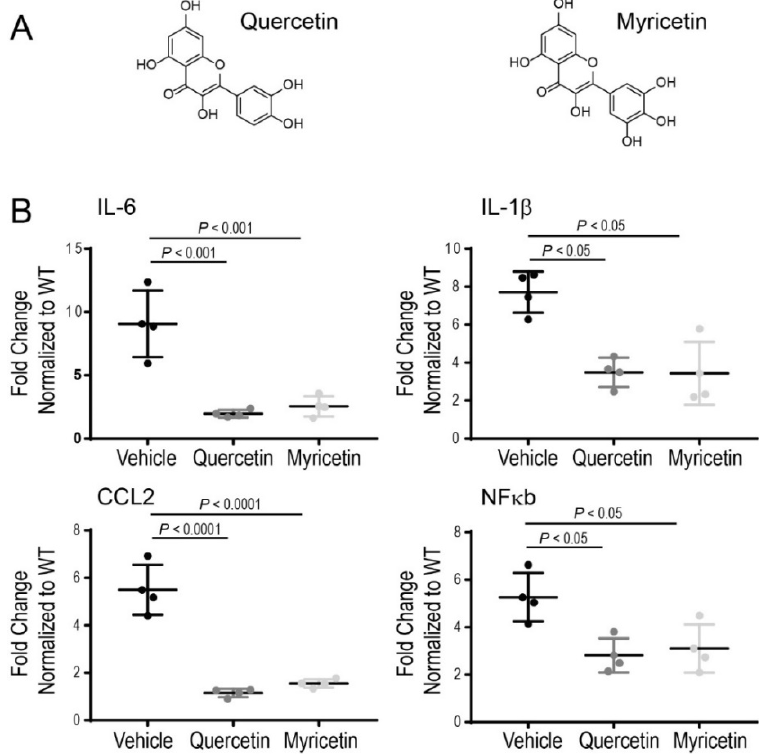
Figure 2. Regulation of the inflammatory markers by flavonoids in the homozygous P23H rhodopsin knock-in mice. ( A ) Chemical structures of two flavonoids, quercetin and myricetin. ( B ) The expression levels of selected inflammatory-response-related genes were examined by RT-qPCR. Mice were treated with quercetin or myricetin from postnatal (P) day 14 to P21 via intraperitoneal injection every other day at a dose of 20 mg/kg body weight. At P21 eyes were collected, and total RNA was isolated from the eyes of mice treated with flavonoids or a vehicle. Five mice were used for each treatment group. The Felative fold change of these genes’ expression was normalized to the expression of Gapdh . Error bars indicate standard deviation. The change in the expression of the analyzed genes was significantly reduced upon treatment with both flavonoids. The p -values for statistically different changes are indicated in the figure. Statistical analysis was performed using one-way ANOVA analysis and Bonferroni post hoc